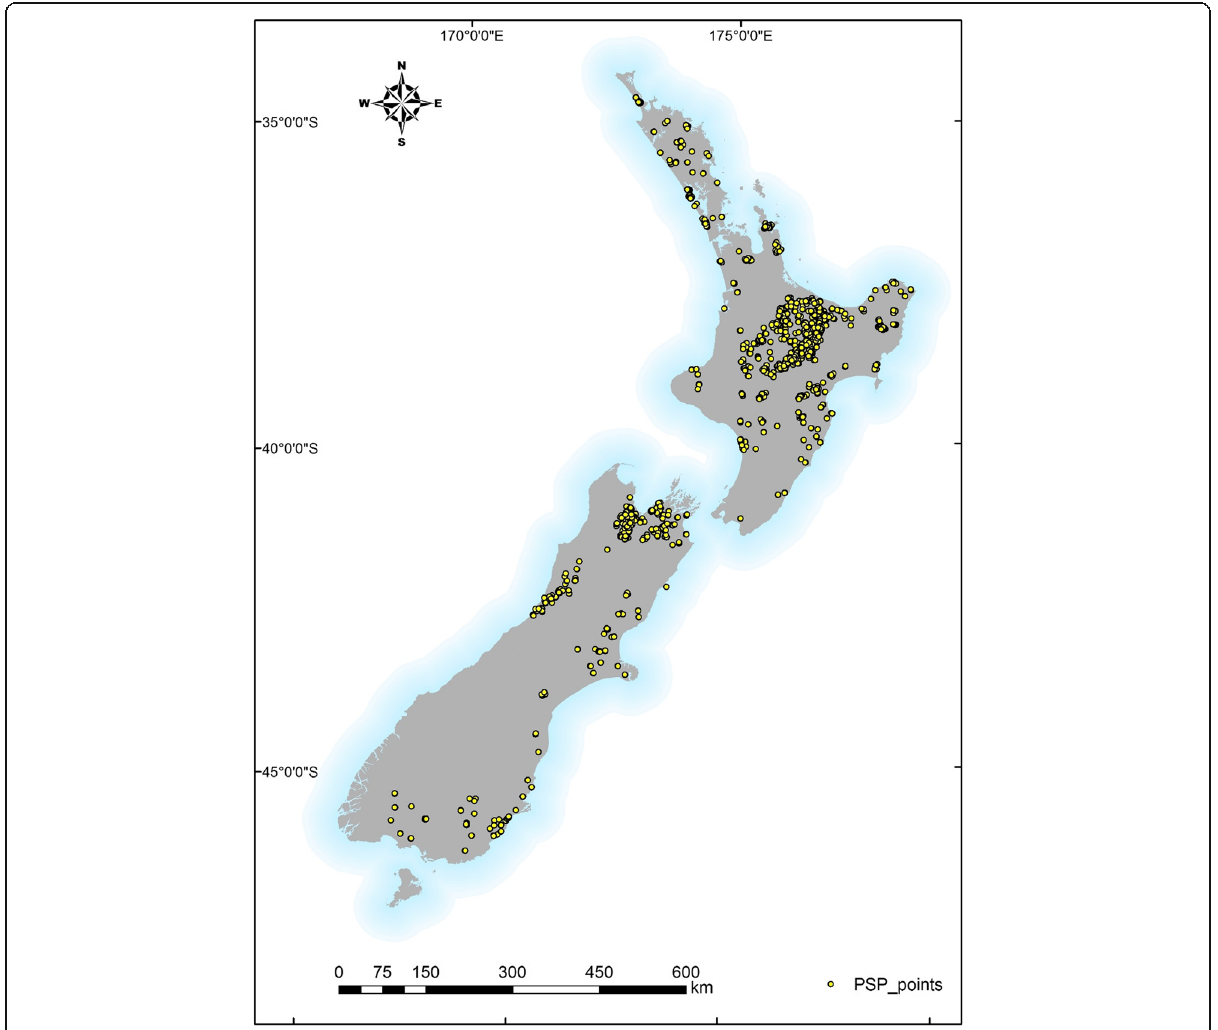
Fig. 1 Title: Locations of PSP plots used to model P. radiata